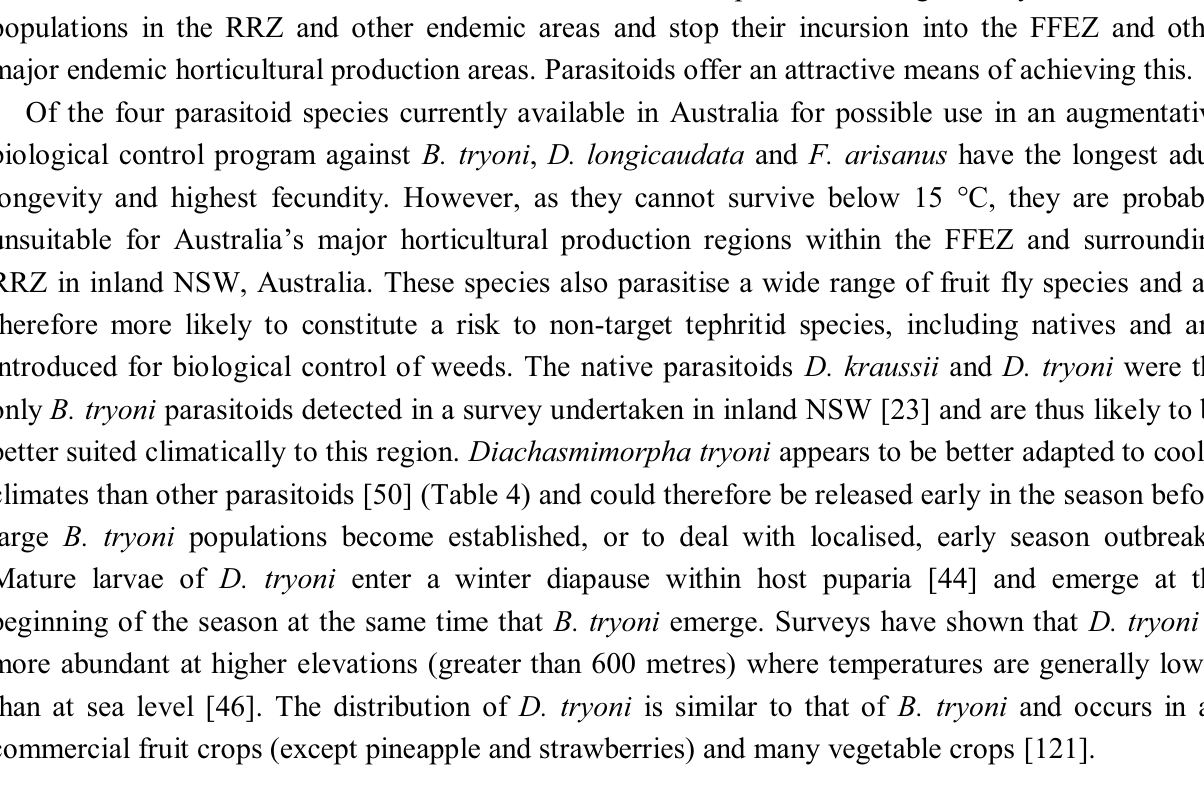
Table 4. Comparison of characteristics for the two Australian native parasitoids